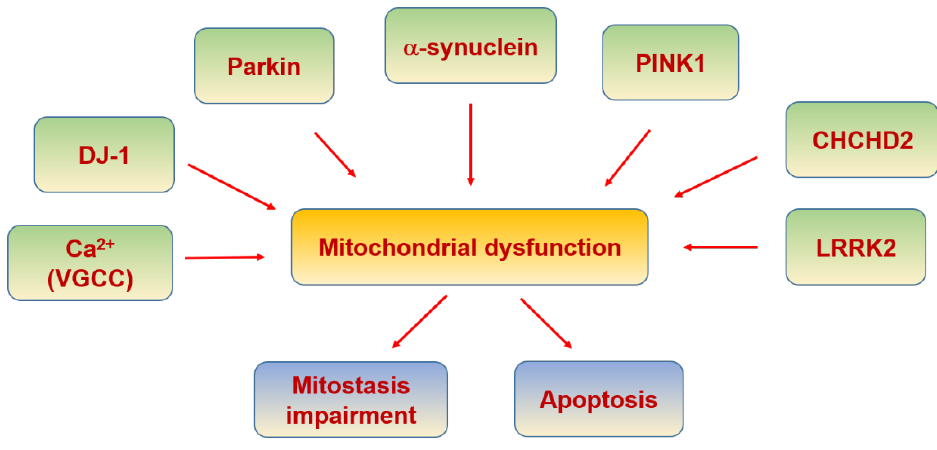
Figure 9. Parkinson’s disease and mitochondria.